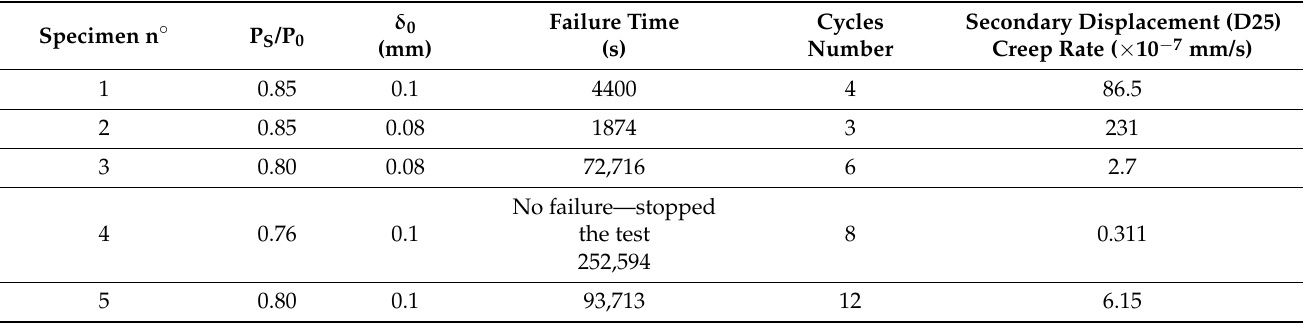
Table 1. Information about the secondary displacement (D25) creep rates related to the speci- mens tested.